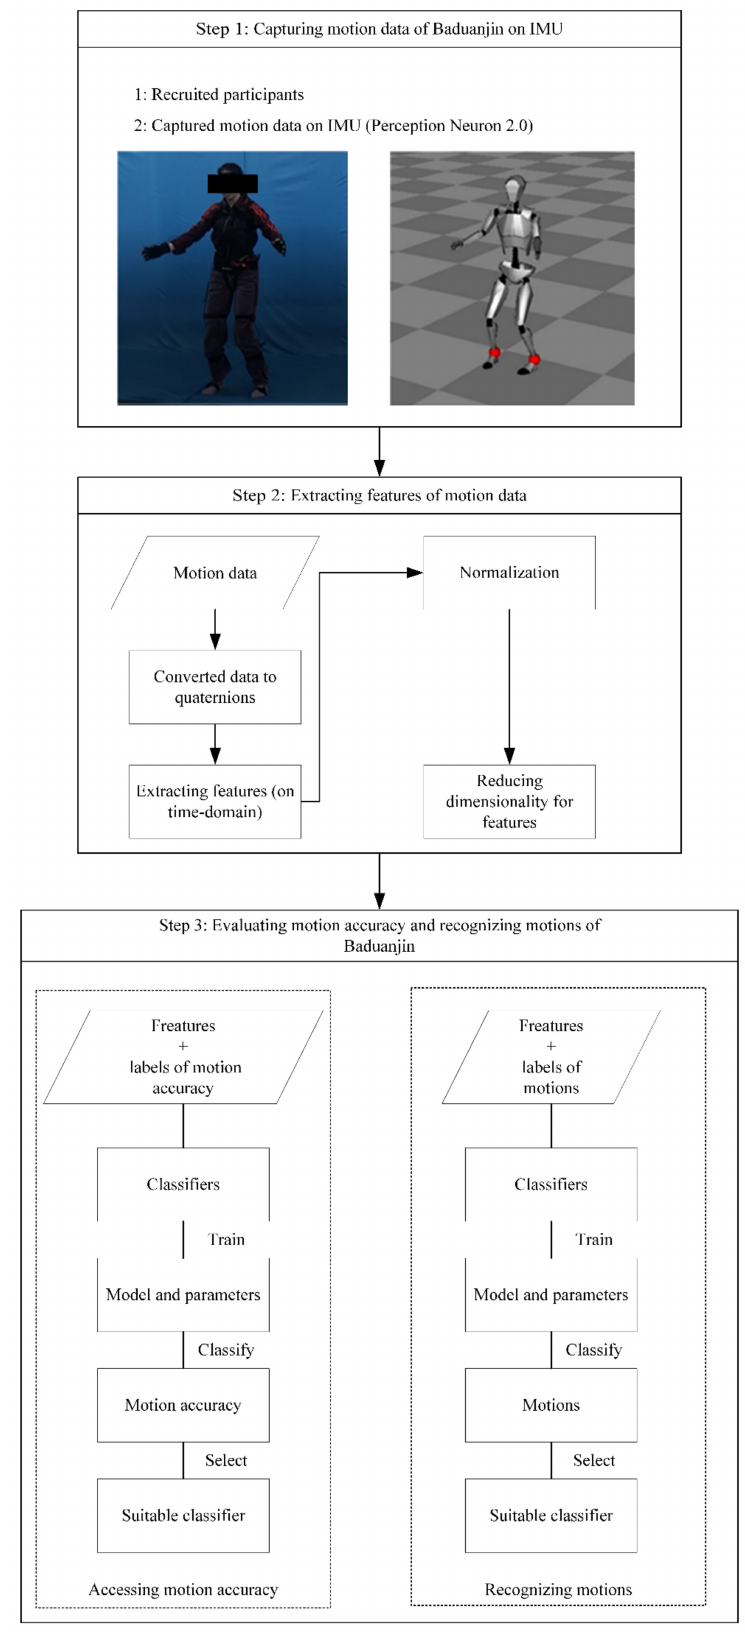
Figure 1. Flow diagrams of the